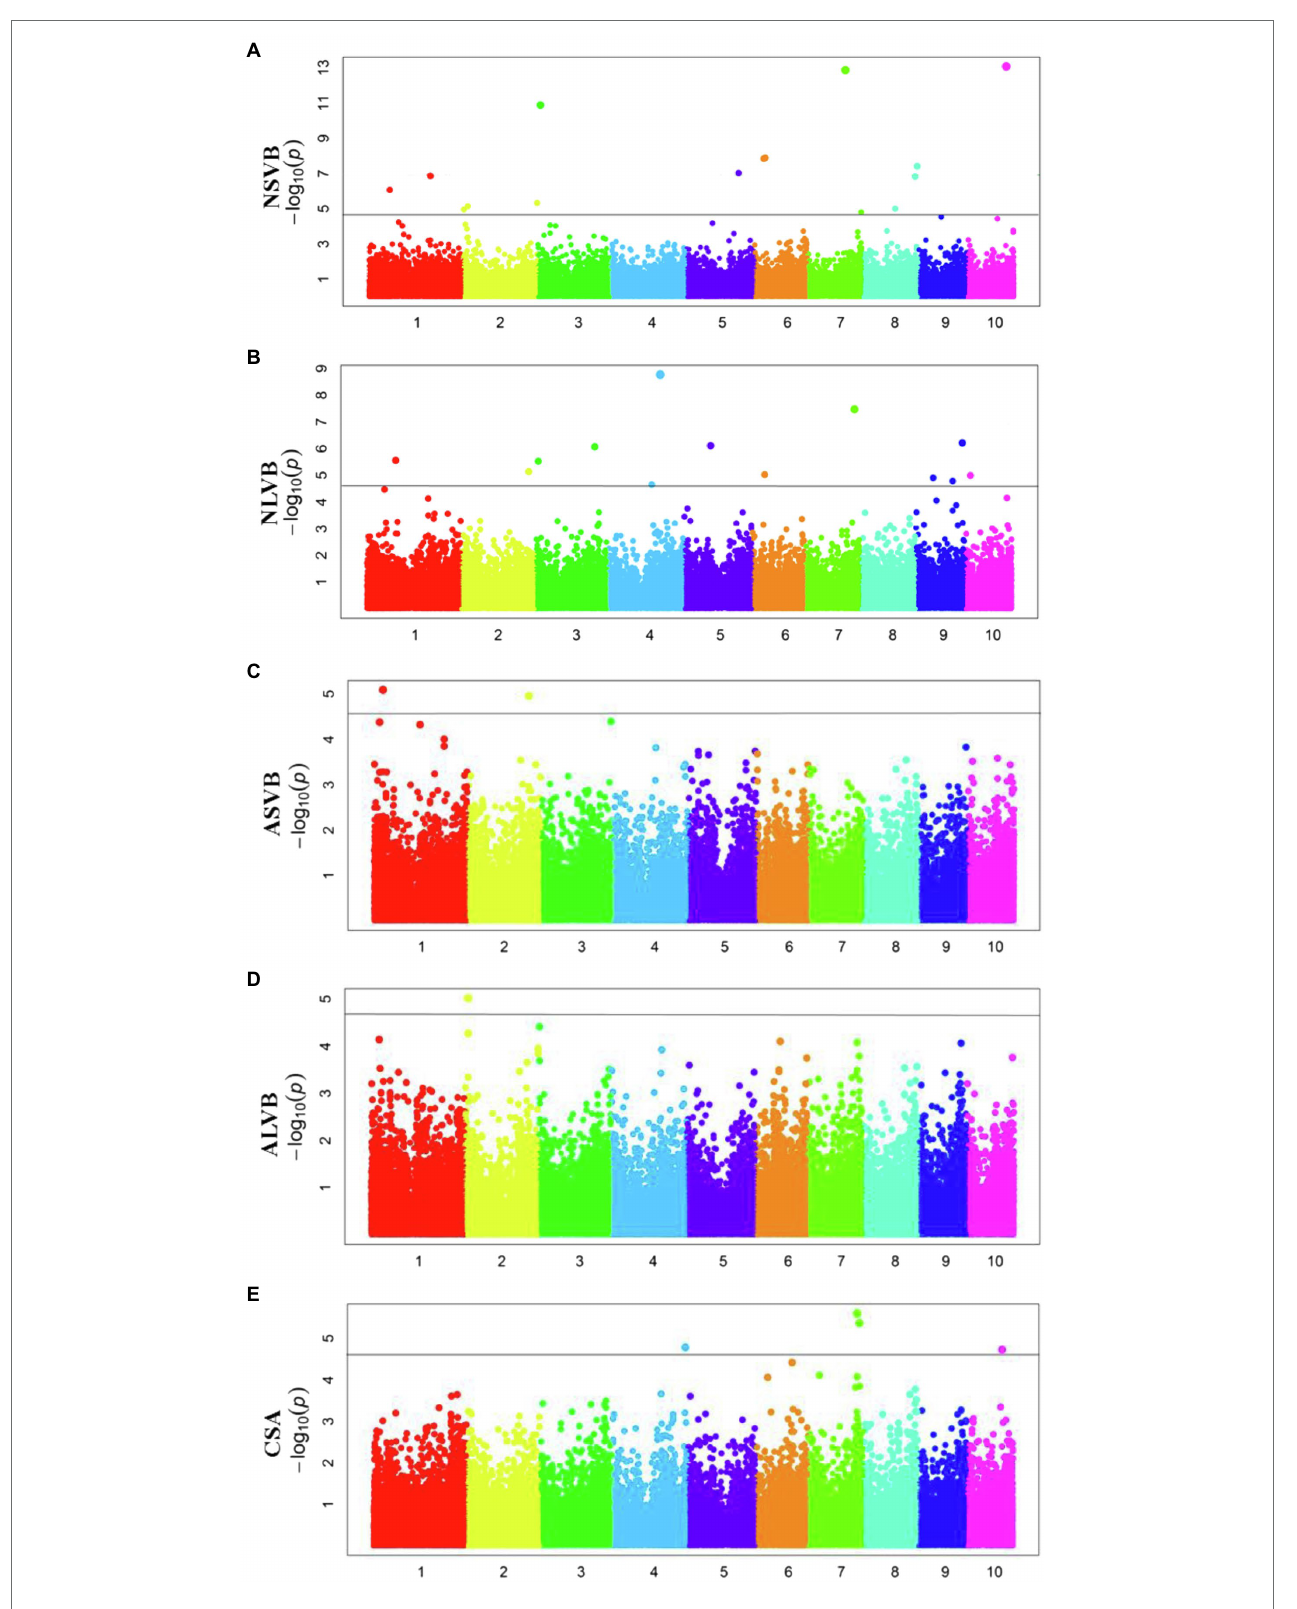
FIGURE 4 | Manhattan plots of GWAS results for (A) NSVB; (B) NLVB; (C) ASVB; (D) ALVB; and (E)